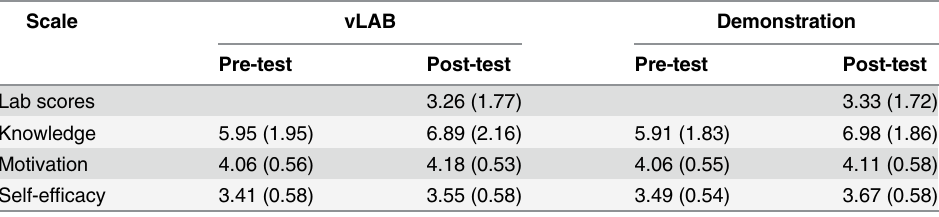
Table 1. Mean scores for the outcome variables in the study in the pre- and post- test for the vLAB and Demonstration groups. Note: Standard deviation is reported in